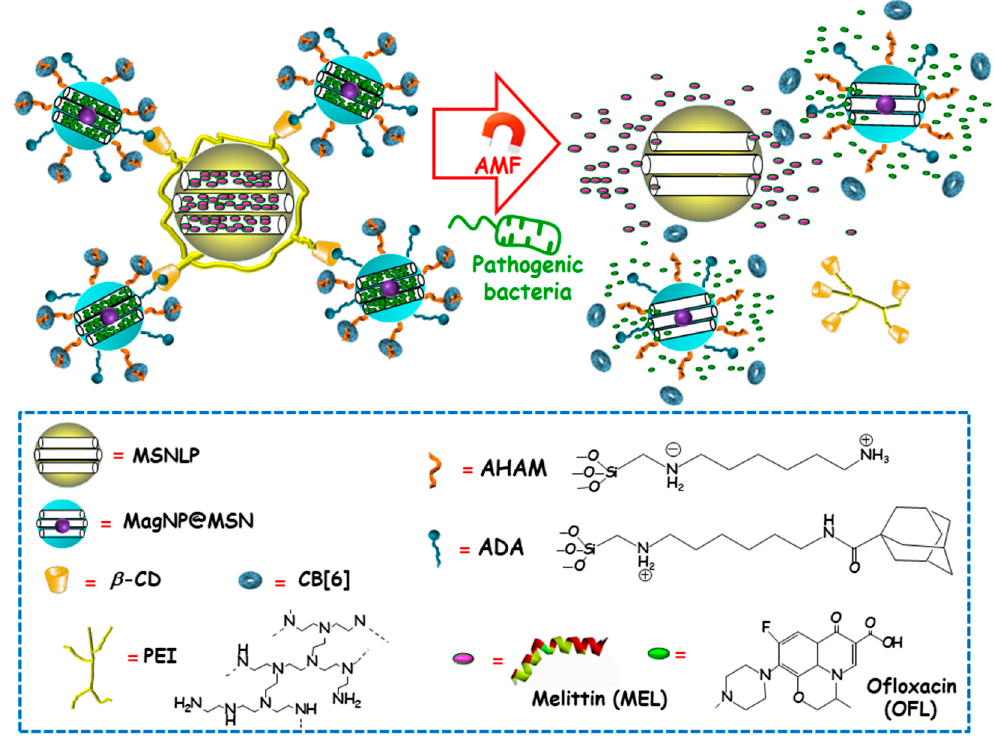
Figure 11. Schematic representation of the operating mechanism of dual drug-delivery and pathogen/heating/alternating magnetic field (AMF)-responsive antimicrobial nanosystems formed by the supramolecular co-assembly of host MSNs (H), guest MSNs (G). H consisted of large-pore MSNs (MSNLP) loaded with melittin (MEL) and capped by β -cyclodextrin ( β -CD)-modified polyethylenimine (PEI). G consisted of MnFe 2 O 4 @CoFe 2 O 4 magnetic NPs coated with a mesoporous silica layer (MagNP@MSN), loaded with ofloxacin (OFL) and decorated with both adamantine (ADA) (to interact with β -CD on the surface of H) and N-(6-N-aminohexyl)aminomethyl triethoxysilane (AHAM) (to interact with cucurbit[6]uril (CB[6])) for efficient pore capping. Adapted from ref. [101]. Dual antimicrobial drug release is triggered by the presence of pathogenic cells and the application of an alternating magnetic field (AMF). 4. Conclusions The rise of AMR and the prevalence of bacterial biofilms make bacterial infection a serious concern threatening global human health. Recent advances in nanotechnology and science of nanomaterials has allowed for engineering NPs for the treatment of infectious diseases. MSNs, particularly, exhibit enormous potential to treat bacterial infection owing to its versatility and capability to integrate multiple functionalities into one single nanoplatform. This review has tried to give a comprehensive overview of the current advances in the design and development of MSNs-based